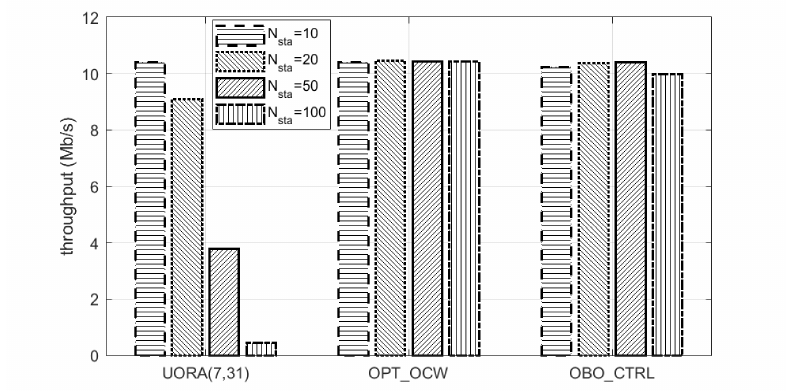
Figure 9. Throughput comparison when the number of RA-RUs was